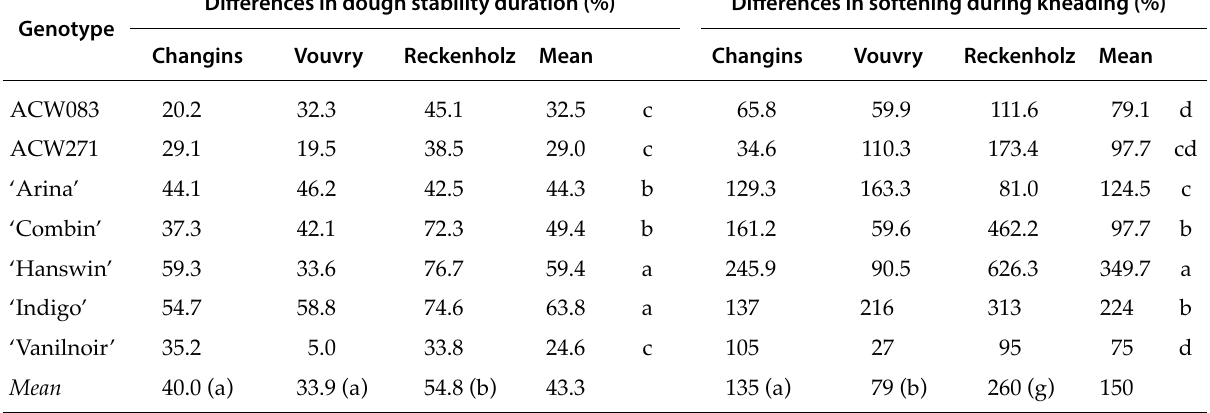
Table 6. Relative differences (%) in dough stability duration and dough softening during kneading resulting from Fusarium inoculation. Differences in dough stability duration are the means of relative reductions due to inoculation. Differences in dough softening during kneading are the means of relative increases due to inoculation. Means followed by the same letter are not significantly different ( P